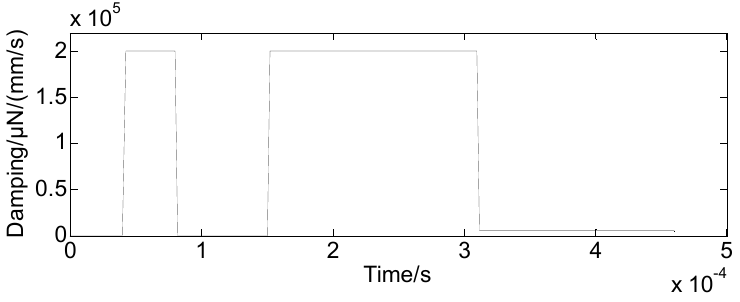
Figure 12. Damping with respect to time.